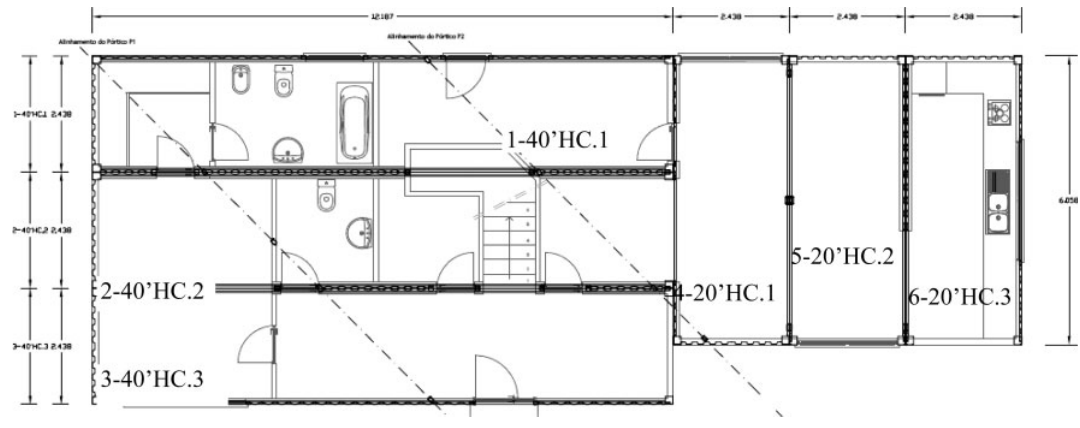
Fig. 12. Configuration: Floor 0